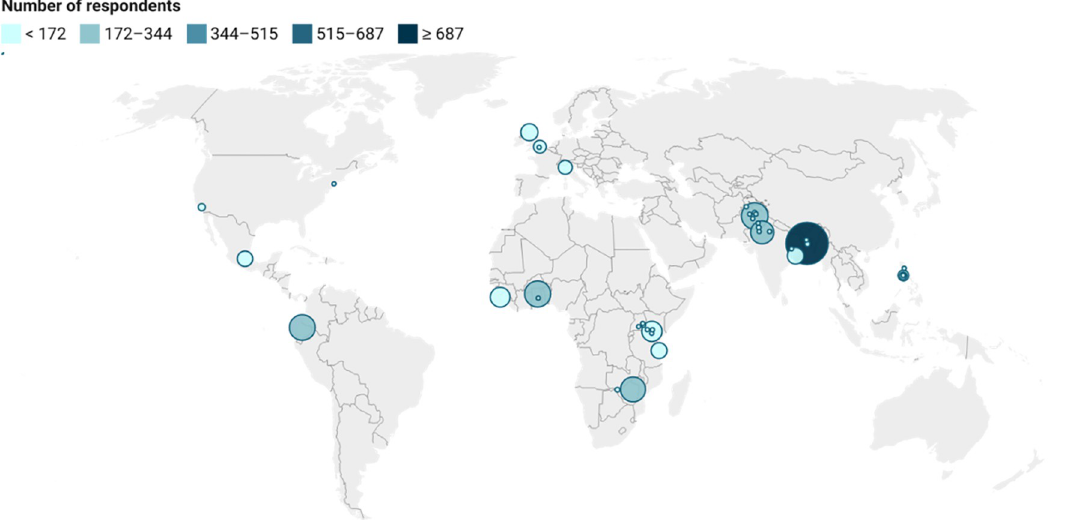
Fig 1. Distribution of survey responses by self-reported city (n =